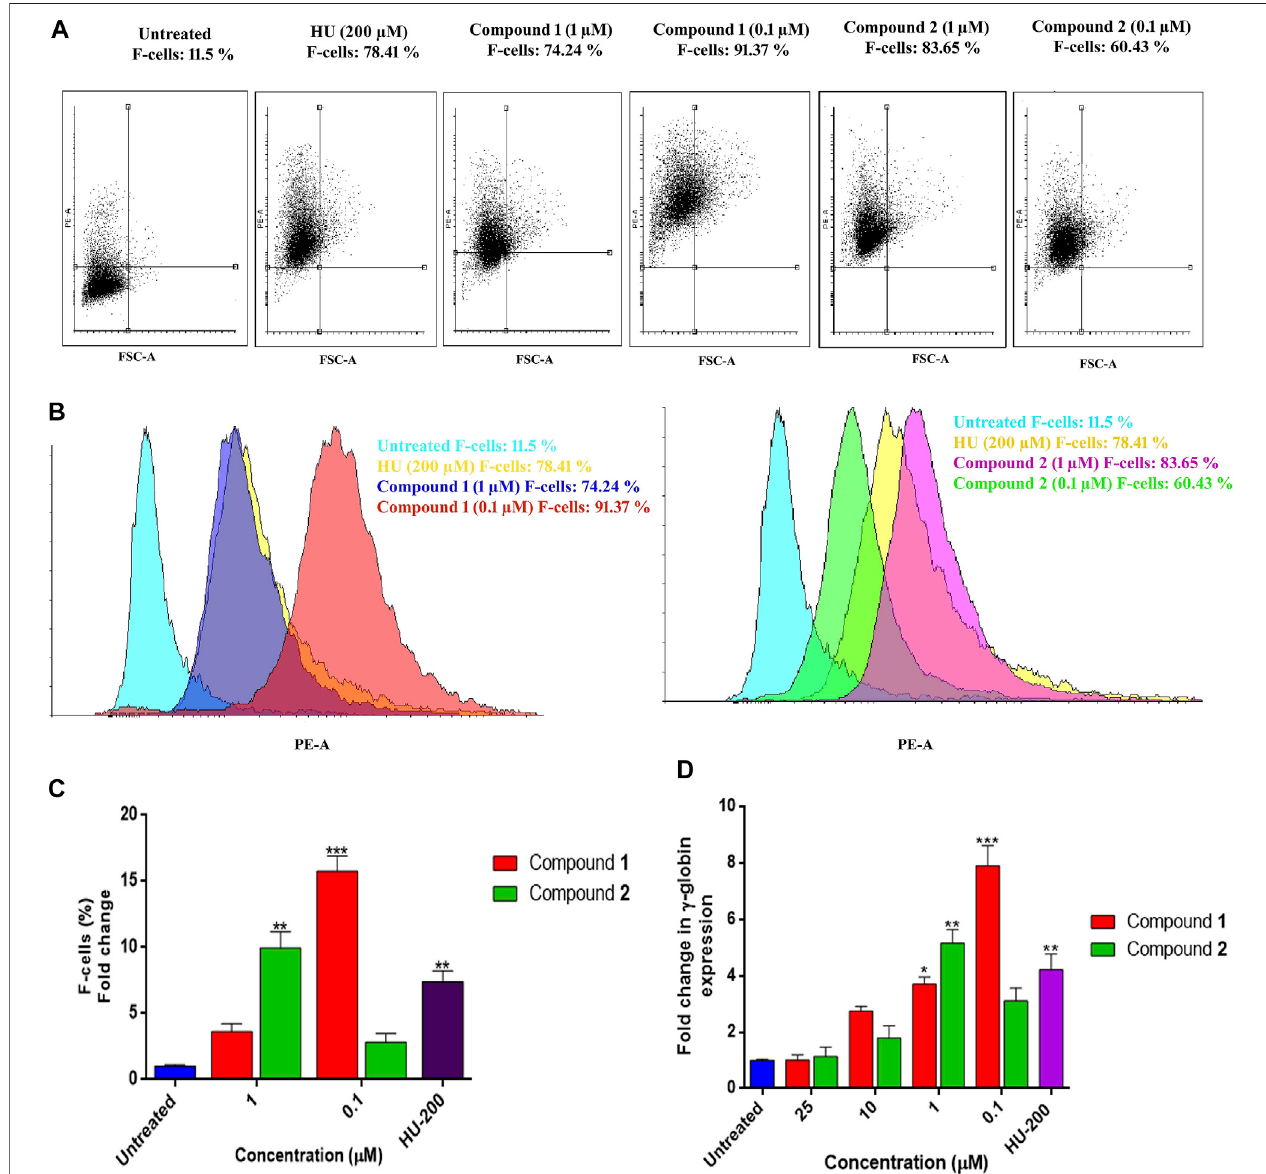
FIGURE 7 | HbF expression analysis by fl ow cytometry and comparative fold change (qRT-PCR) analysis of γ -globin gene expression in K562 cells by lead compounds. (A) DotplotsdepictingtheHbF-positivecellsstainedwithanti-HbFantibodiesobservedthroughthePEchannel. (B) Thehistogramdemonstratedthelevel of F-cells (HbF-containing cells) were upregulated by the treatment of lead compounds at different inducing concentrations. (C) The bar graph showed percentages of HbF-induced F cells in comparison to untreated and HU treated cultures. Data showed (mean ± SEM) are from three separate experiments. (D) The γ -globin expression level was normalized to the level of corresponding GAPDH. The signi fi cant differences (* p < 0.05) between compounds treated and the untreated control were analyzed by one-way